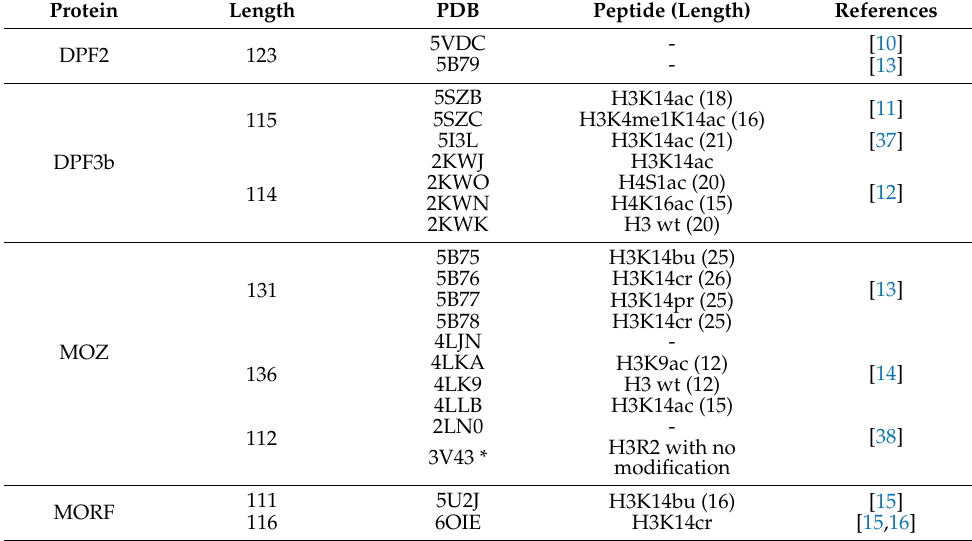
Table 1. DPF domains structures as of